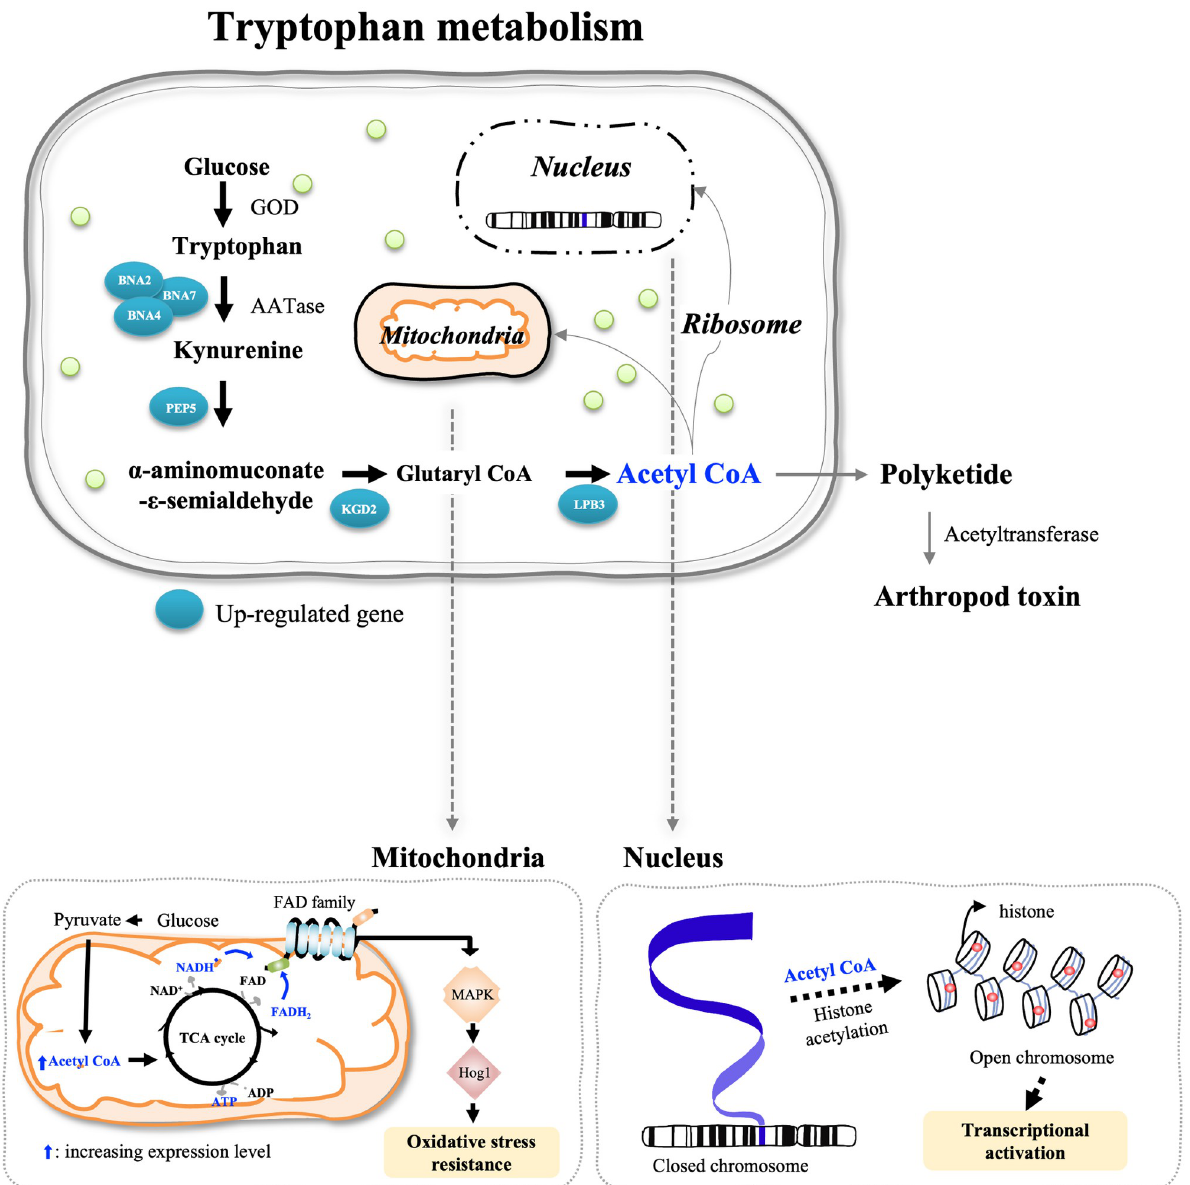
Fig 7. Analysis of enriched of tryptophan metabolism pathway that B . bassiana JEF-410 were infected red mite were infected at early stage. (A) Summarized acetyl-CoA synthesis pathway and secondary metabolite synthesis pathway of BNA2 dioxygenase, BNA4 kynurenine 3-monooxygenase, BNA7 arylformamidase, PEP5 tethering complex subunit, KGD2 alpha-ketoglutarate dehydrogenase, LPB3 acetyl-CoA C-acetyltransferase; PK, polyketide. (B) Histone acetylation is responsible for synthesis of acetyl-CoA and amplification of DNA expression level. (C) The Hog1 pathway for overcoming oxidative stress in mitochondria starts from acetyl-CoA; MAPK mitogen-activated protein kinase; Hog1 branched MAPK signal transduction system.